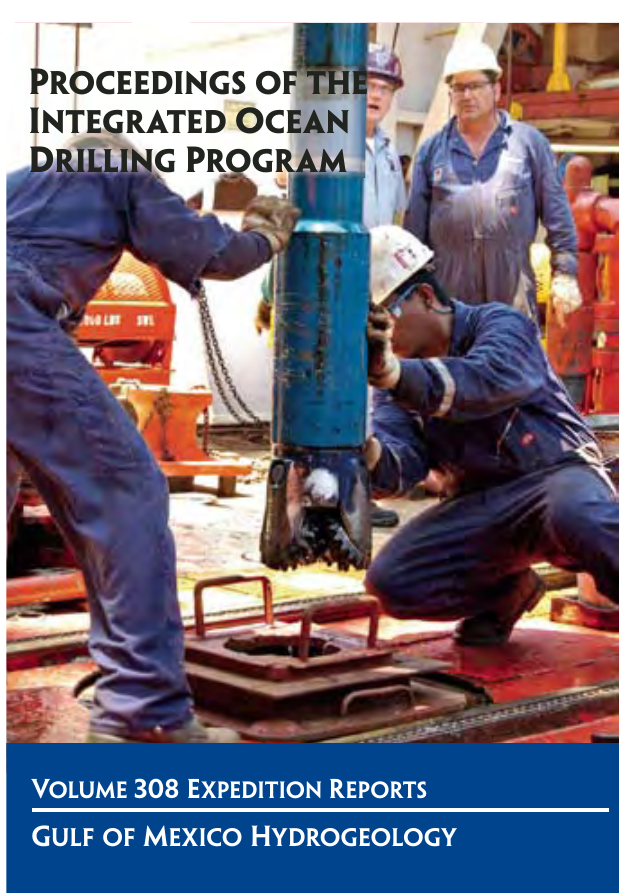
Figure 2. Cover of Volume 308 DVD of Proceedings of the Integrated Ocean Drilling Program published in